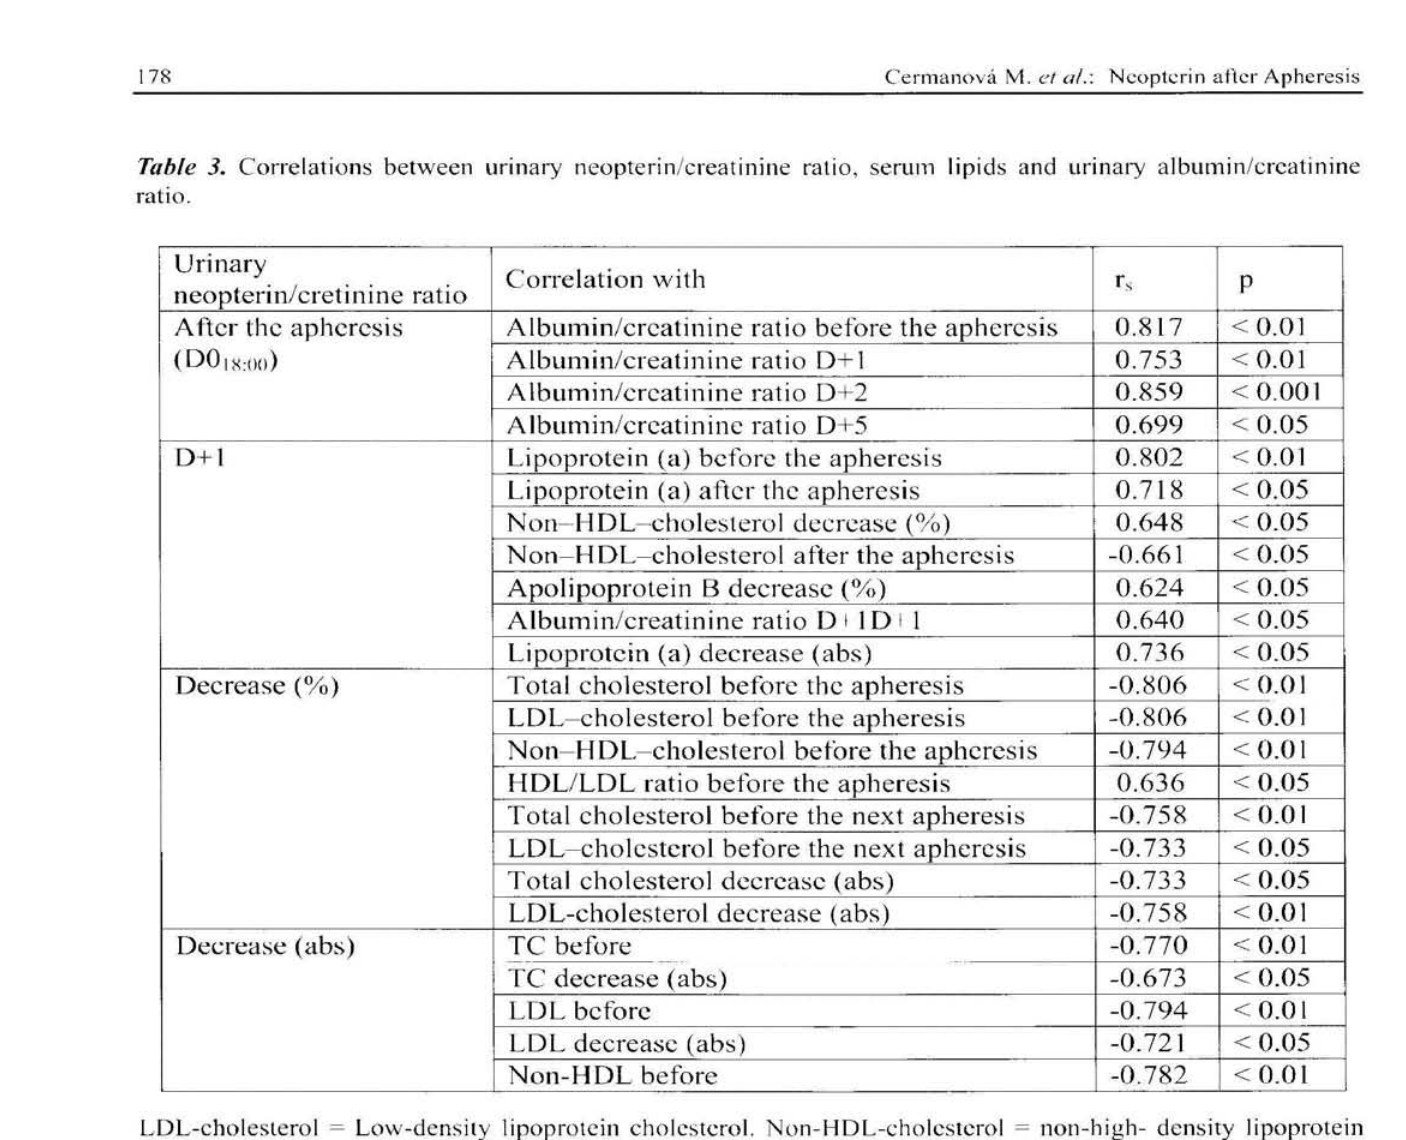
Table 3. Correlations between urinary neopterin/creatinine ratio, serum lipids and urinary albumin/crcatinine